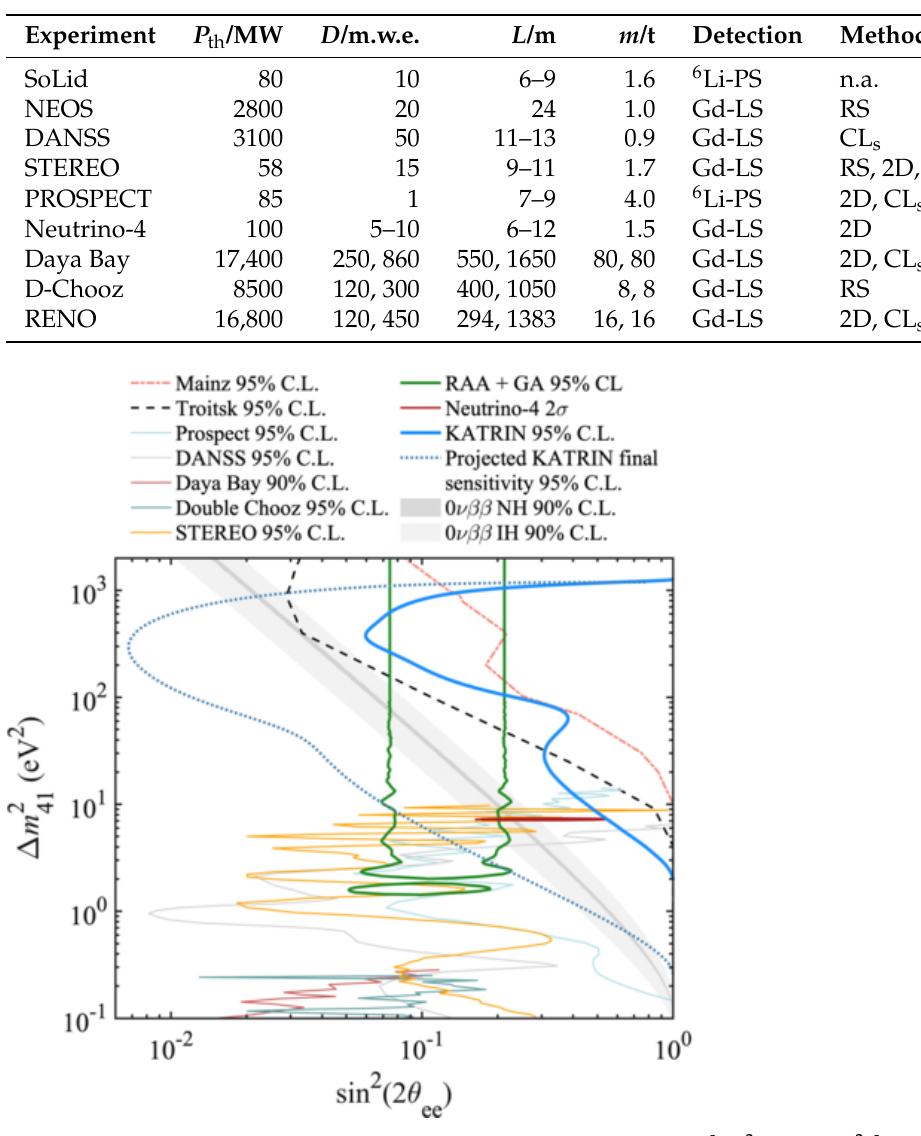
Figure 1. Exclusion contours of all reactor experiments in the plane of the allowed contours of the RAA and Gallium anomaly as well as Neutrino-4. KATRIN’s current and expected exclusion limits are shown in addition. Reprinted from [29] under CC BY